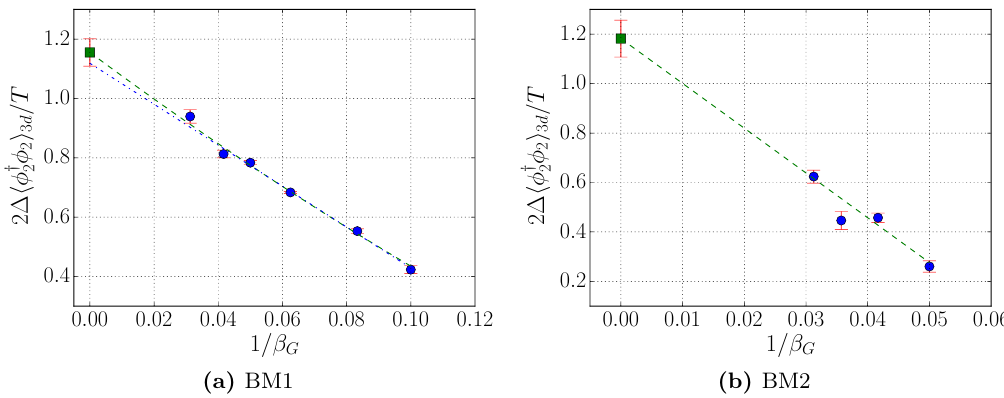
Figure 5. Continuum extrapolations of the order parameter discontinuity in the in(cid:12)nite-volume limit. Both quadratic (green) and linear (blue) (cid:12)ts are shown in BM1. A reliable higher-order polynomial (cid:12)t in BM2 would require the use of very large (cid:12) G | and consequently extremely large lattices | due to the very massive scalar degrees of